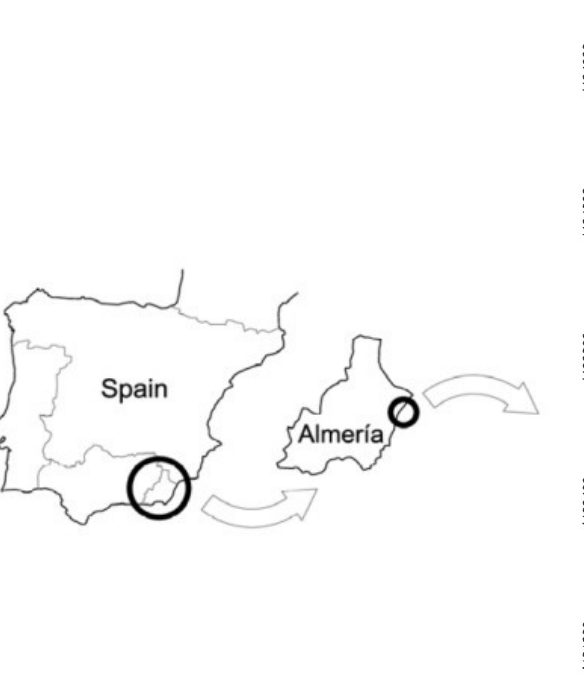
Figure 1. The location of the study area (red rectangle) using aerial orthophotographs from the Spanish Programme of Aerial Orthophotography (PNOA) in 2010. Coordinate system: WGS84 UTM zone